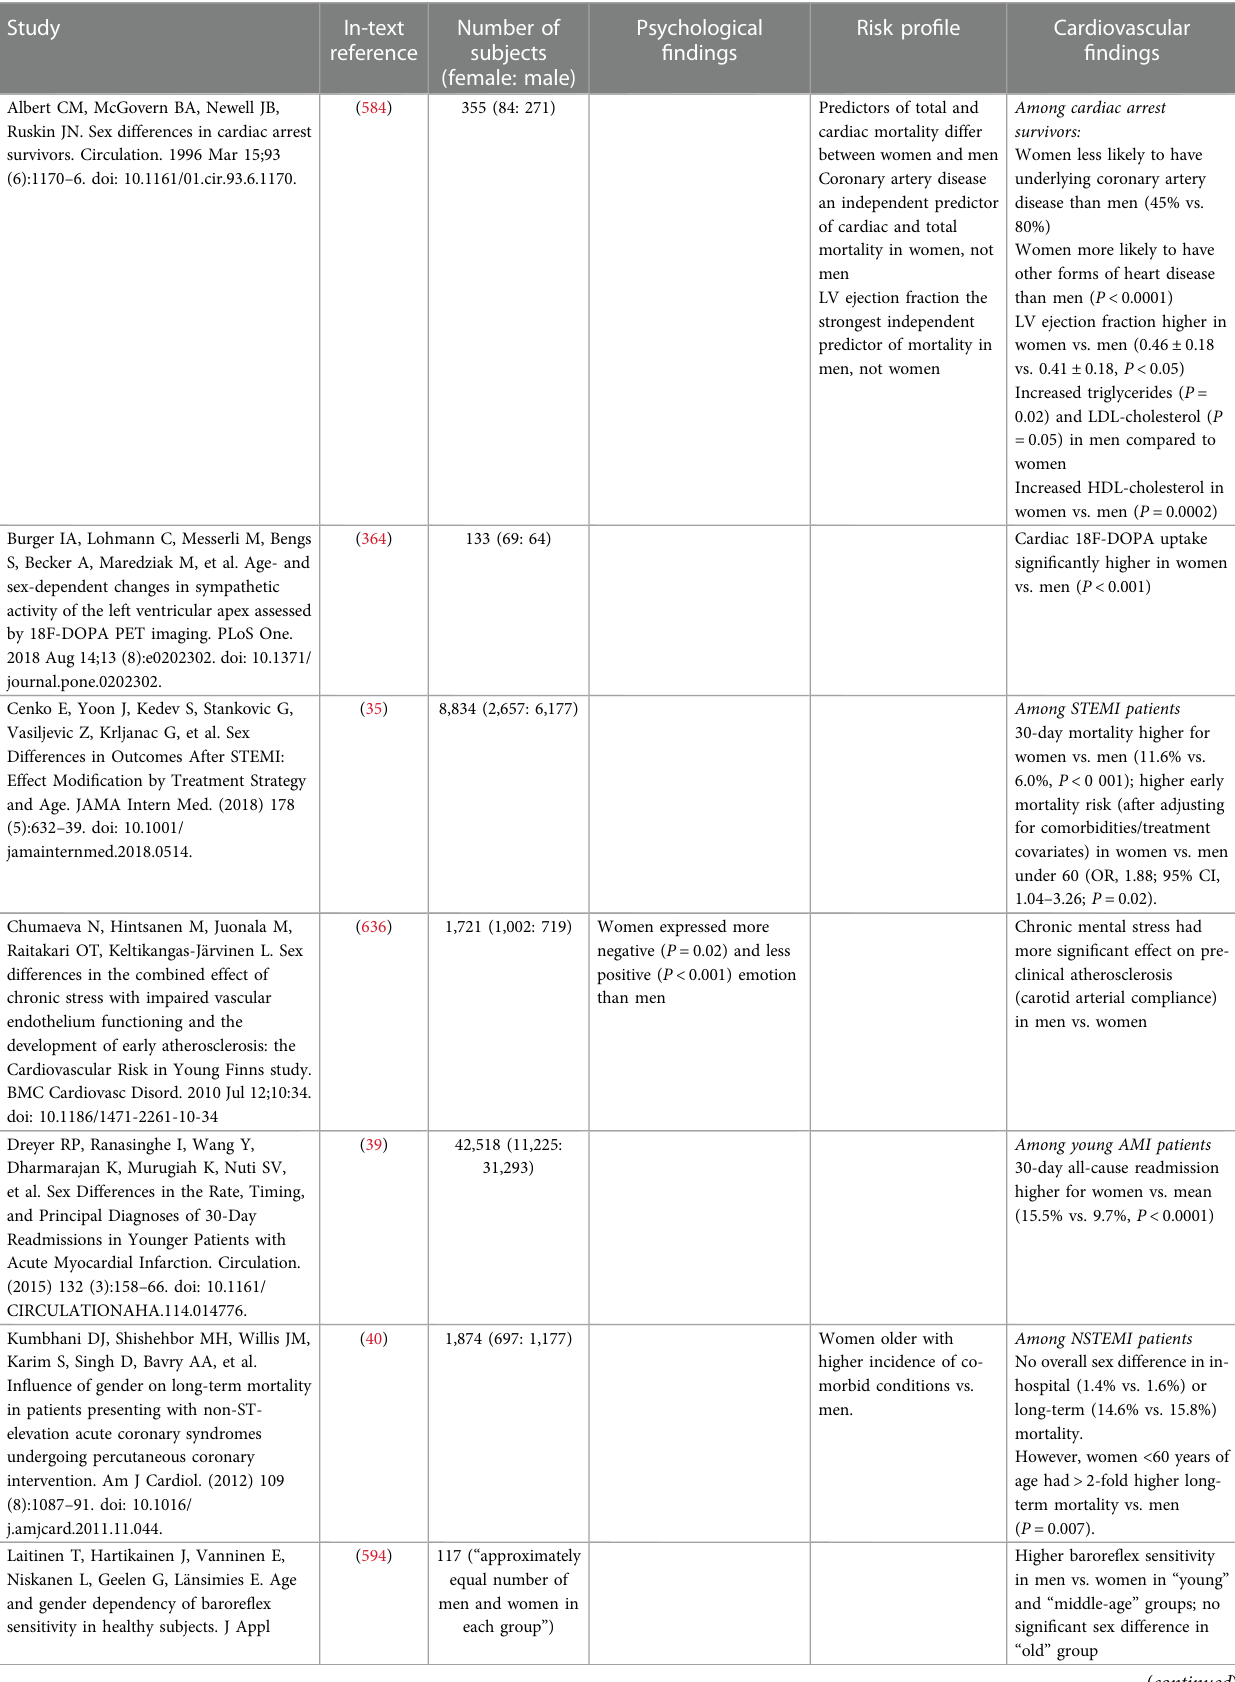
TABLE 1 Summary of studies assessing sex dependent cardiovascular outcomes and disease risks. Study In-text